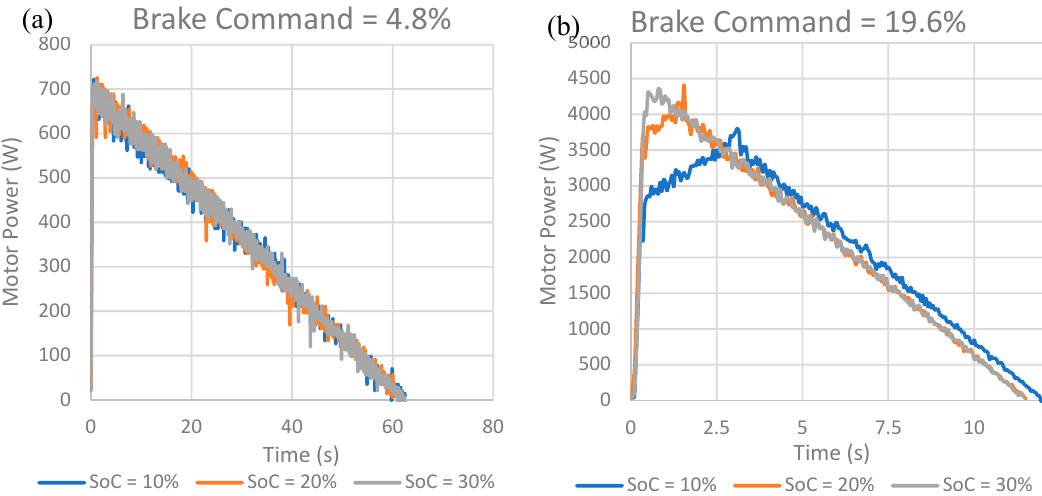
Figure 5. ( a ) Motor output power for a 4.8% brake command; ( b ) motor output power for a 19.6% brake command.